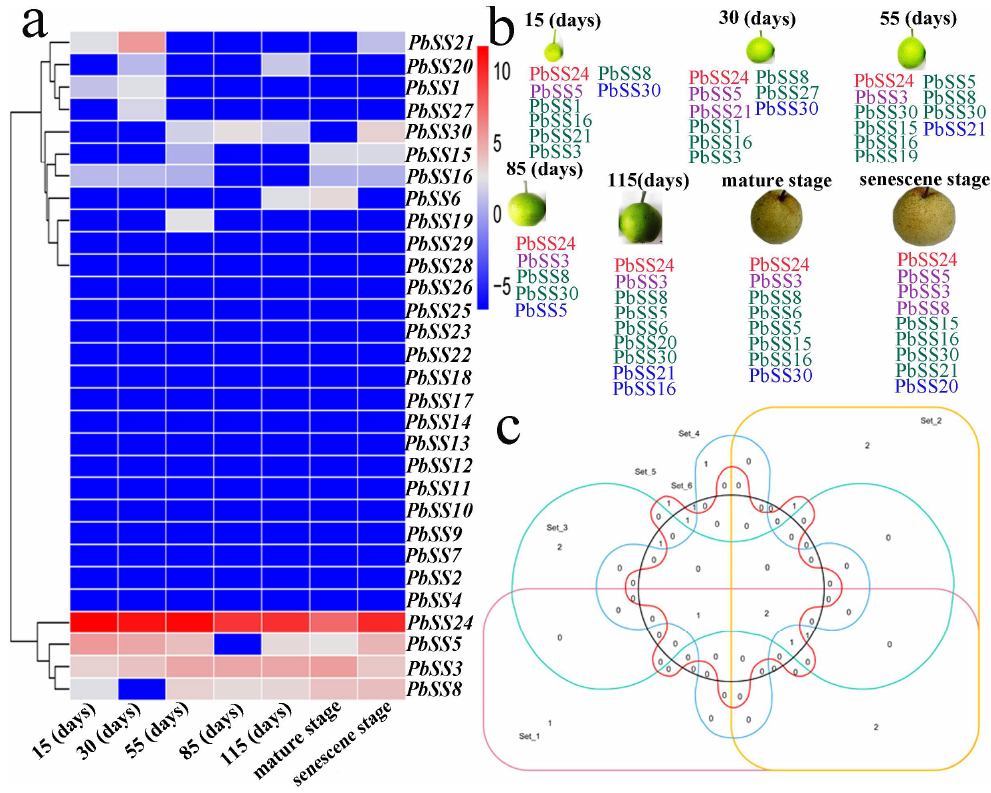
Figure 6. Expression pattern of PbSSs genes. ( a ) Organ-specific expression pattern of PbSSs genes in seven fruit development stages: 15, 30, 55, 85, 115 (DAF), mature stage and senescence stage. Blue and red indicated lower and higher transcript abundance, respectively. ( b ) Highly expressed PbSSs genes in pear fruit. According to the previous studies [24], blue, green, violet red, red indicated low (1–6.8 FPKM), mid-low (6.8–17.5 FPKM), mid-high (17.5–44.7 FPKM), and high (44.7–17,092 FPKM) expression, respectively. ( c ) Venn diagram of PbSSs genes in different fruit development stages.